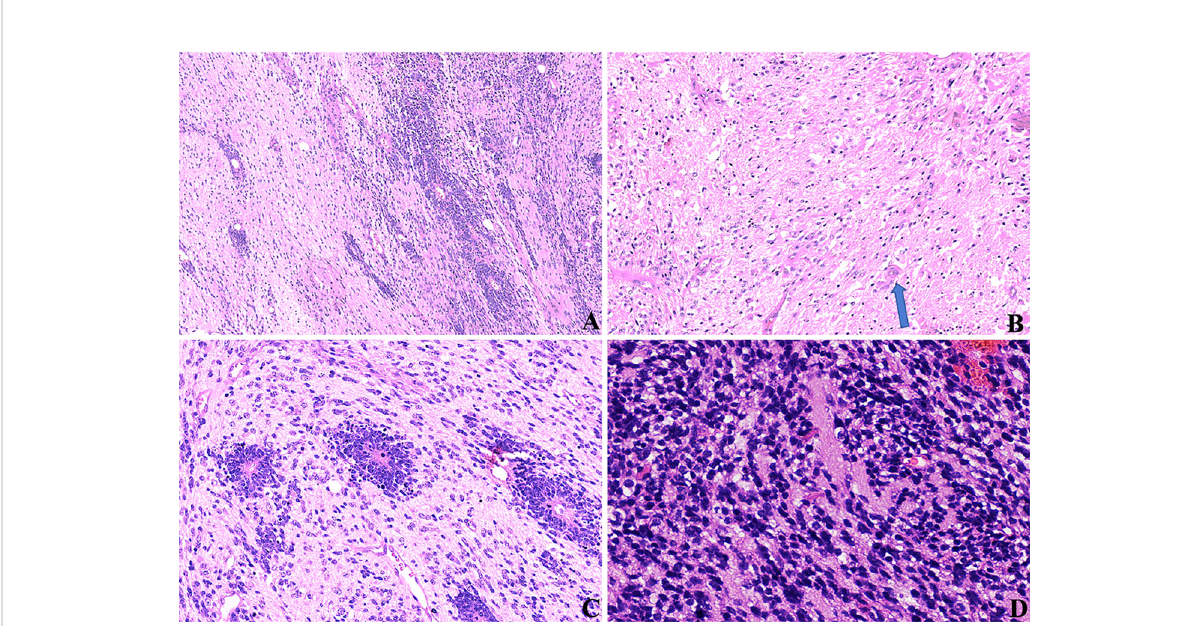
FIGURE 3 HE stainings of ETMRs for case 1, (A) tumor cells were in a biphasic architecture featuring dense clusters of mall embryonal cells/multilayered rosettes and paucicellular neuropil-like areas (×100); (B) Sparse neoplastic neurocytic and ganglion cells could be observed in the neuropil-like matrix (blue arrow, ×200); (C) Multilayered rosettes comprised embryonal cells in a pseudostrati fi ed neuroepithelium with a central round or slit-like lumen; The cells facing the lumen have a de fi ned apical surface with a prominent internal limiting membrane; The nuclei of the rosette- forming cells tended to be located away from the lumen towards the outer cell border (×200); (D) small embryonal cells were with round or polygonal nuclei and scant cytoplasm (×400).